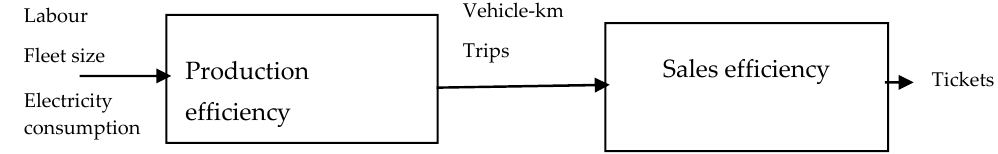
Figure 1. Series two-stage data envelopment analysis (DEA) approach.